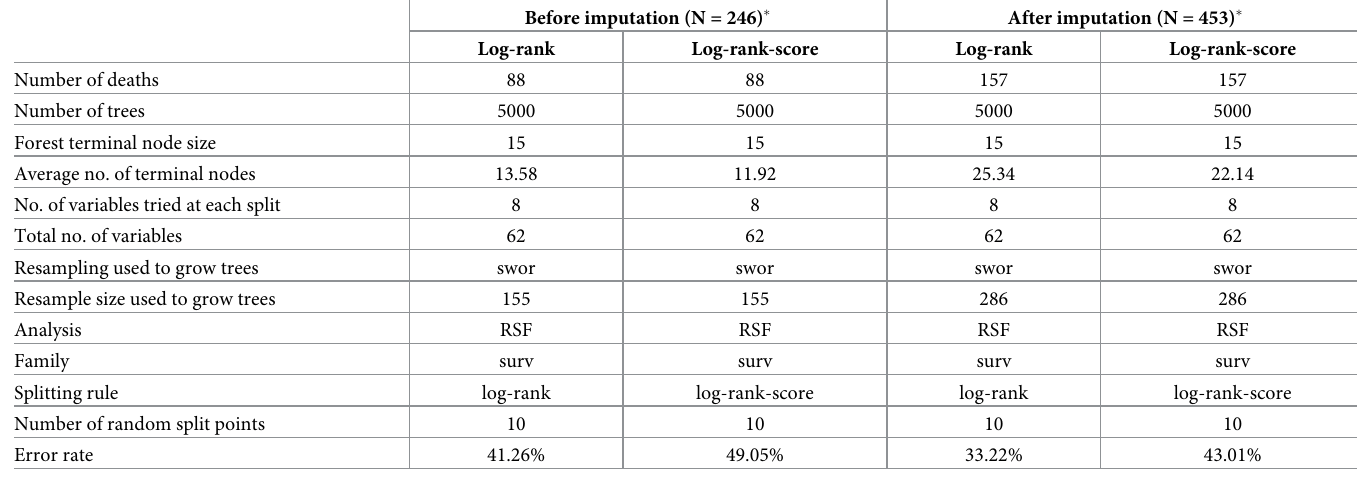
Table 5. Random survival forests results before and after imputation using log-rank and log-rank-score split rules. Before imputation (N = 246)